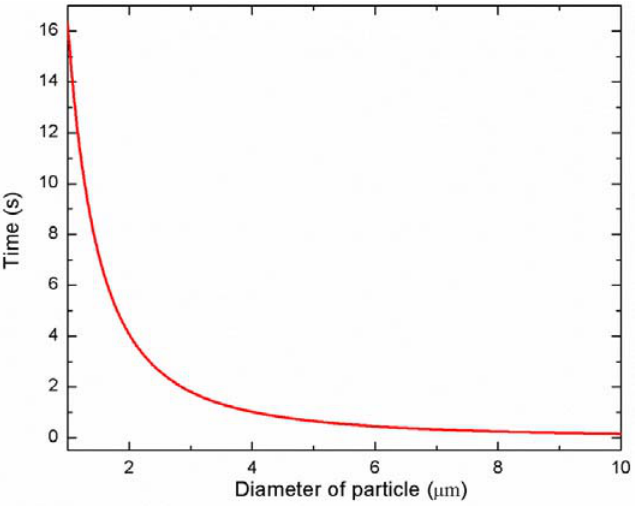
Figure 4. Time required for the particle migration toward the pressure node as a function of particle